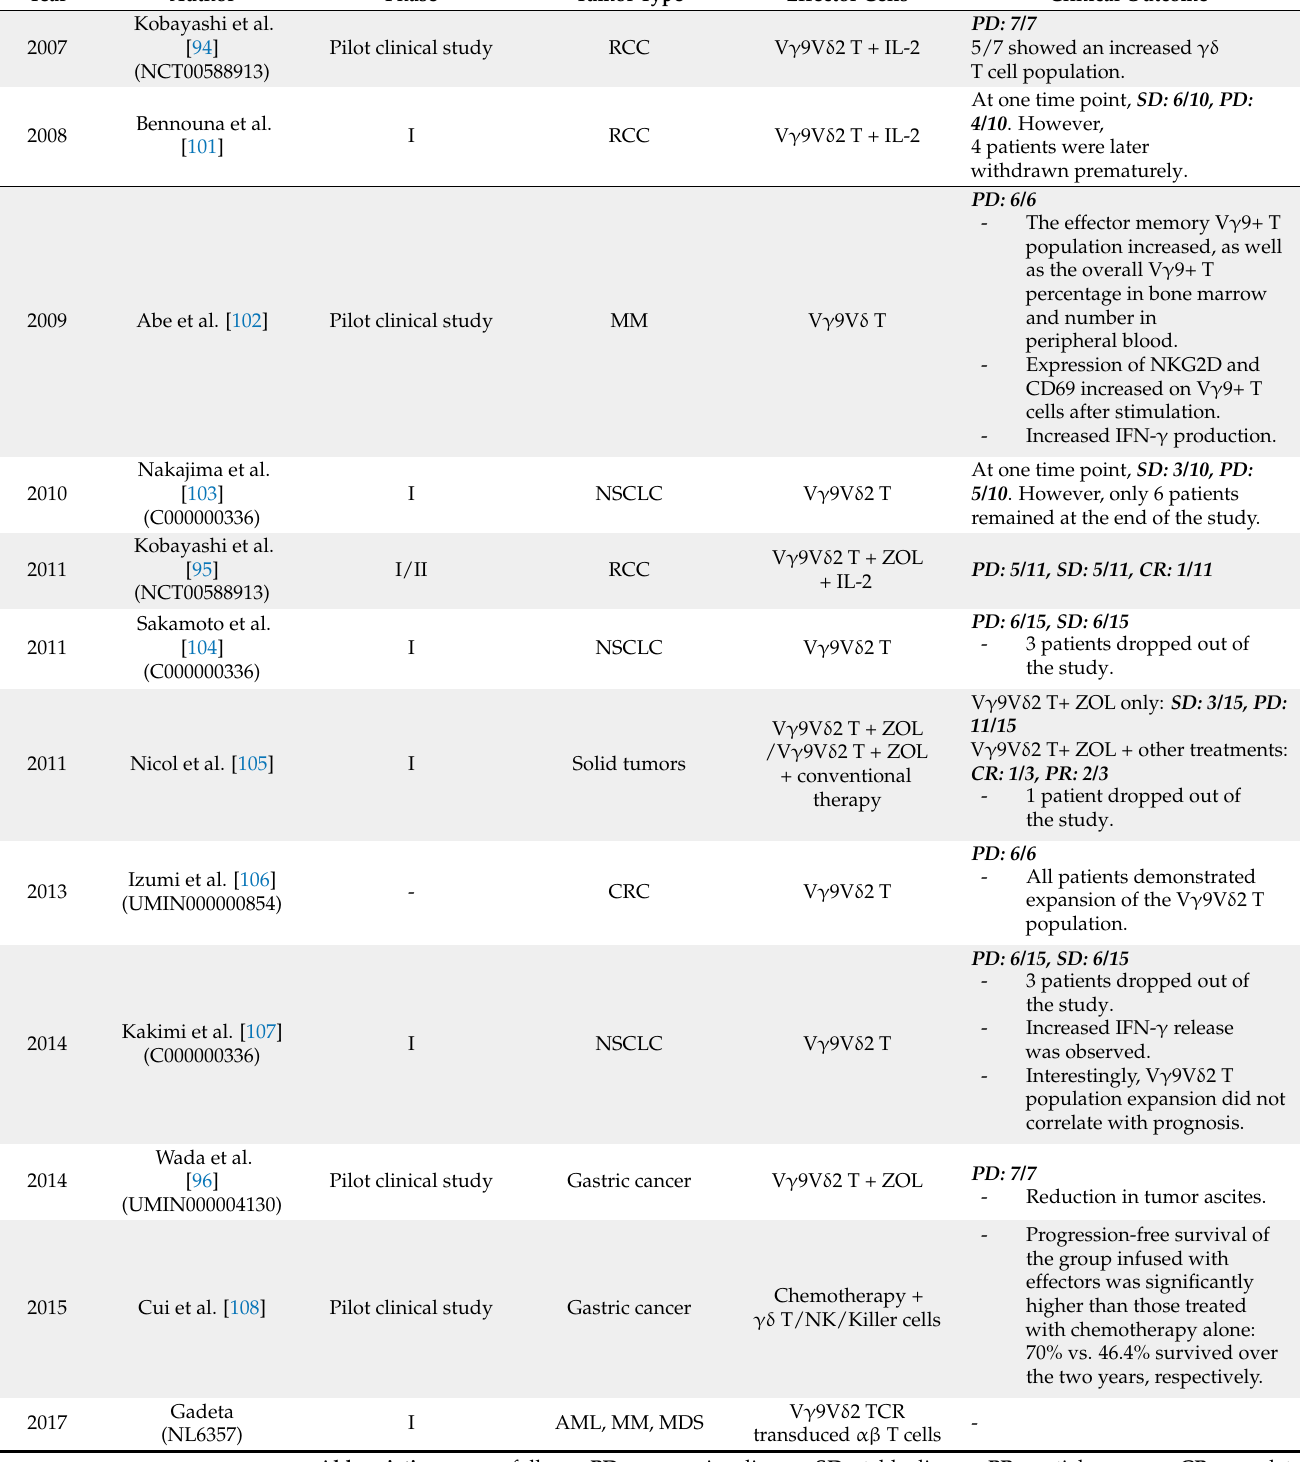
Table 2. Autologous, ex vivo expanded γδ T cell clinical